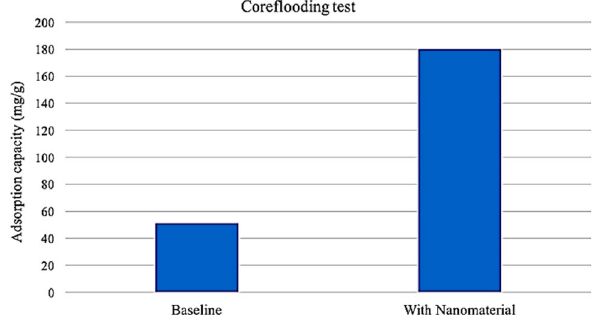
Fig. 7 Adsorption capacity of EDTA on core samples